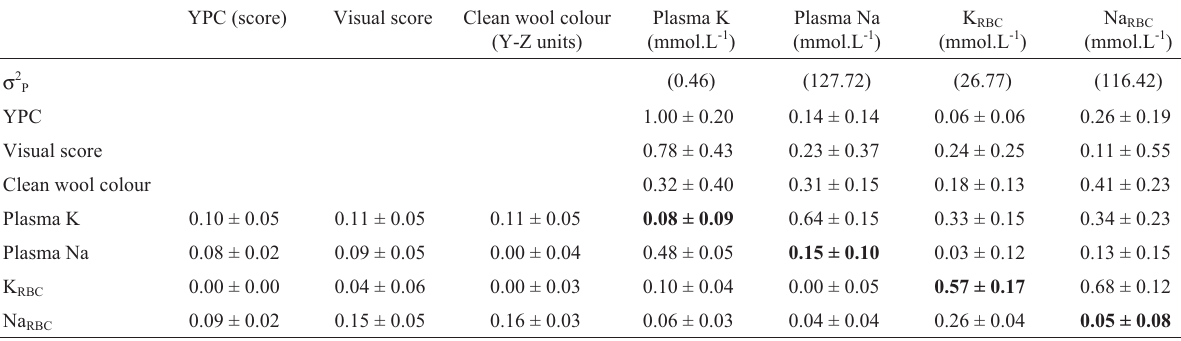
Table 3 - Estimates for genetic (above diagonal) and phenotypic (below diagonal) correlations ( ± standard error) between YPC, Visual score and clean wool colour and blood minerals analysed in Corriedale flock. Hereability estimates are shown in bold.